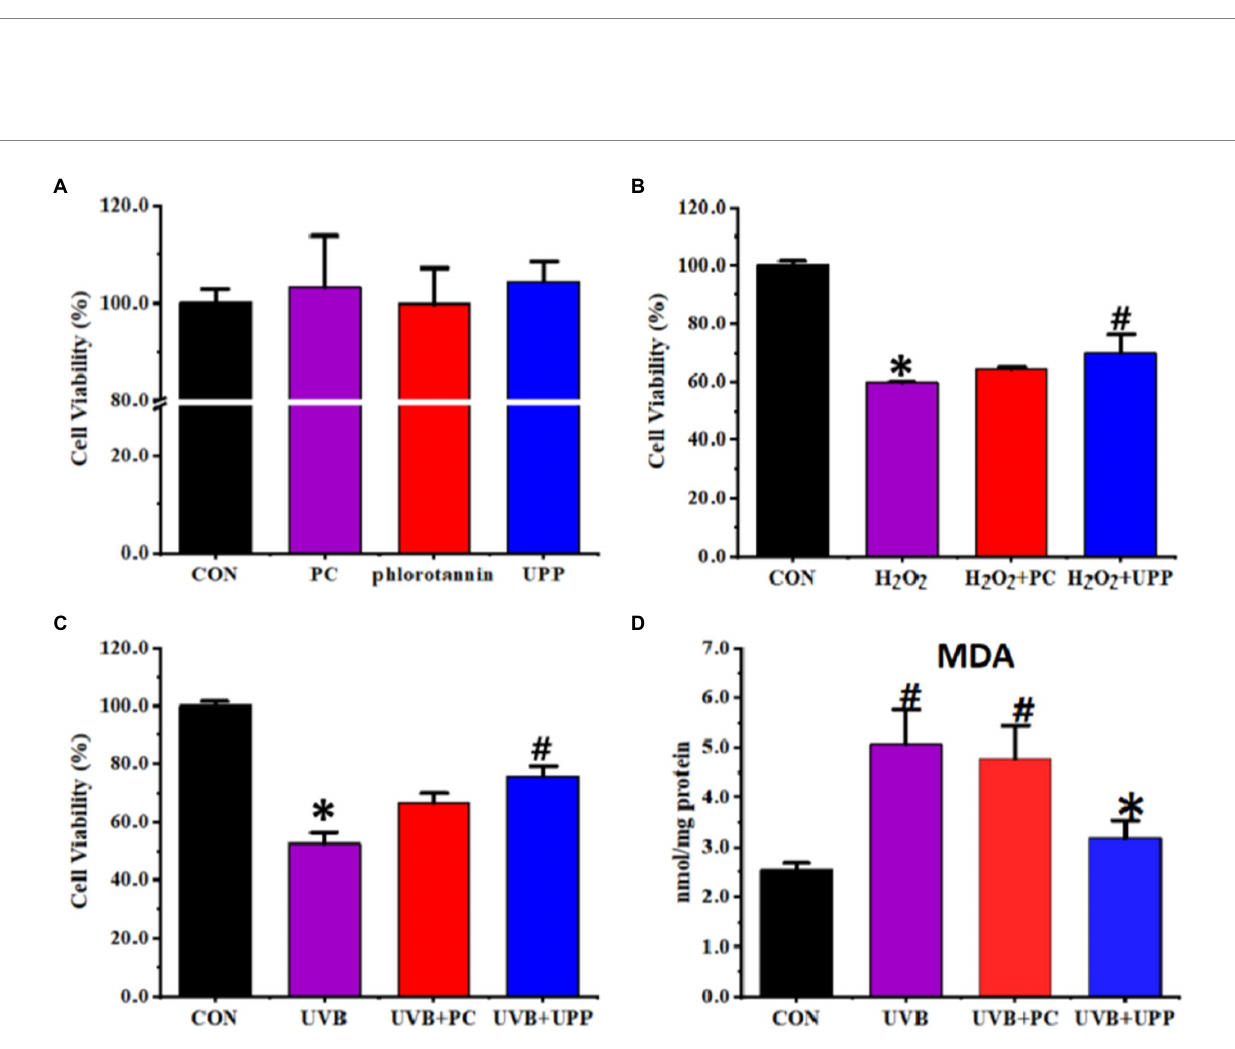
FIGURE 6 Effects on the RMCs of (A) Cytotoxicity, (B) cell viability stimulated by hydrogen peroxide, (C) cell viability induced by UVB, and (D) MDA levels induced by UVB. Different letters represent significant ( p < 0.05) differences between